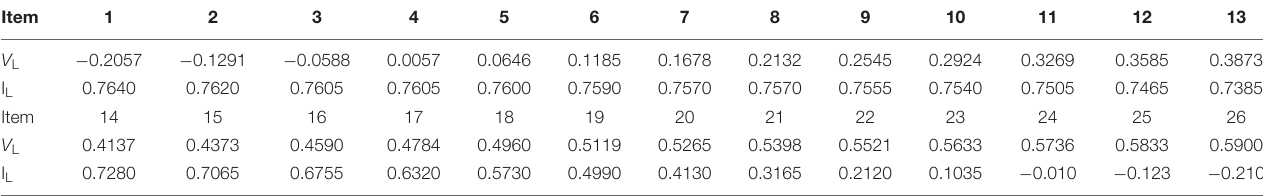
TABLE 4 | Benchmark experimental I-V dataset.